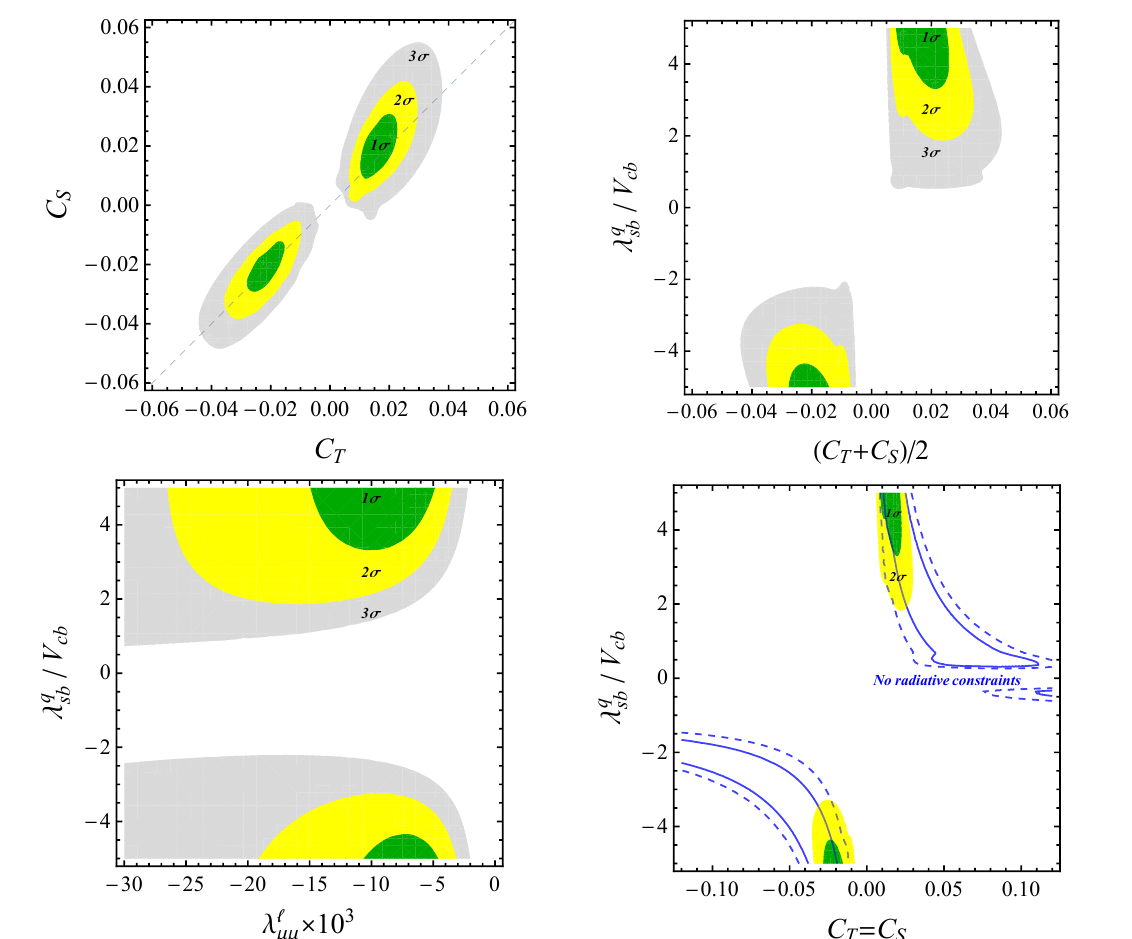
Figure 1 . Fit to the semi-leptonic and purely leptonic (radiatively generated) observables in table 1, in the framework of the triplet and singlet V (cid:0) A operators (see eq. (2.1)), imposing j (cid:21) q In green, yellow, and gray, we show the (cid:1) (cid:31) 2 (cid:20) 2.3 (1 (cid:27) ), 6.2 (2 (cid:27) ), and 11.8 (3 (cid:27) ) regions, respectively, after marginalising over all other parameters. In the bottom-right plot we (cid:12)x C T = C S and perform a (cid:12)t with and without the radiatively induced